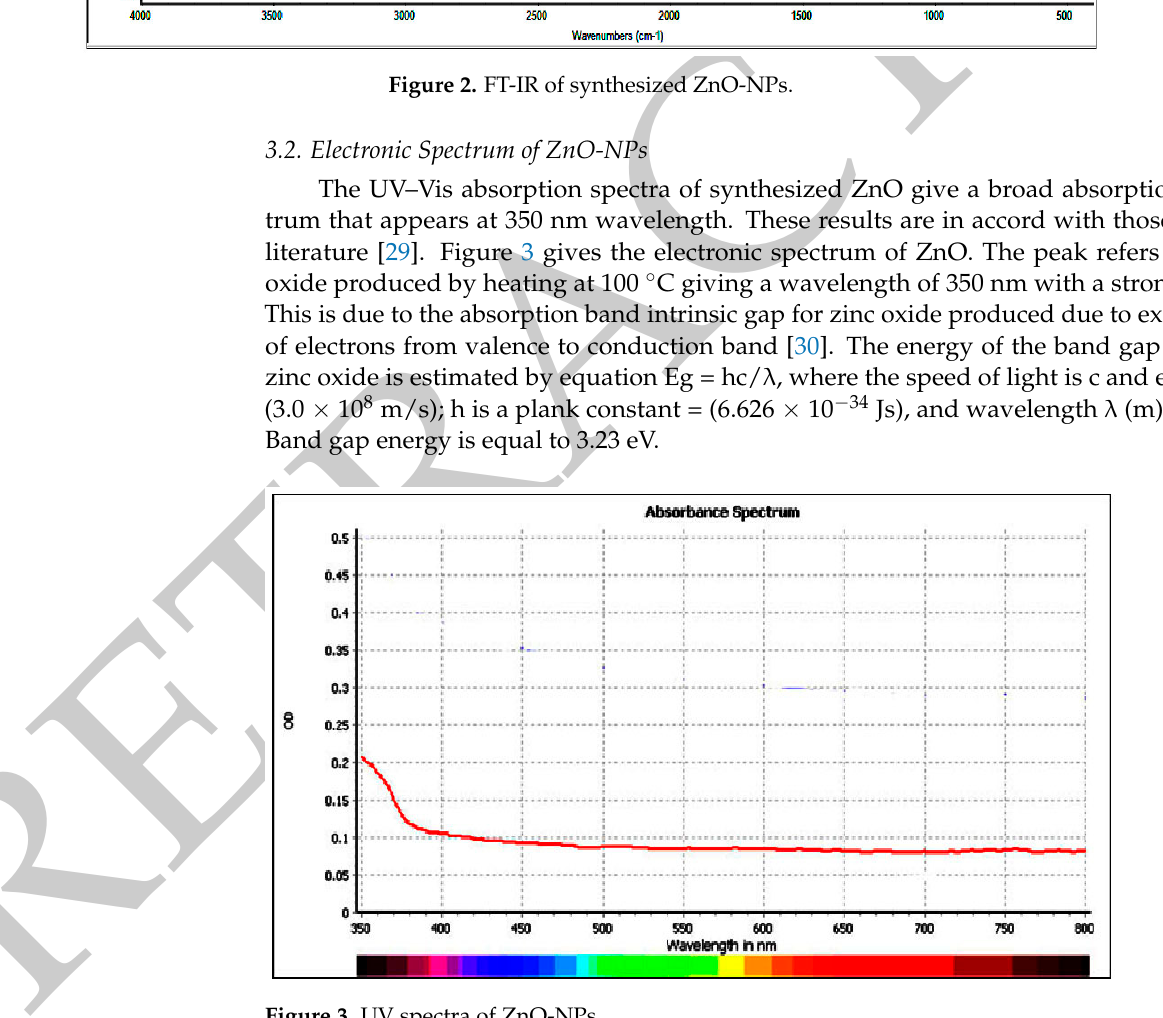
Figure 3. UV spectra of